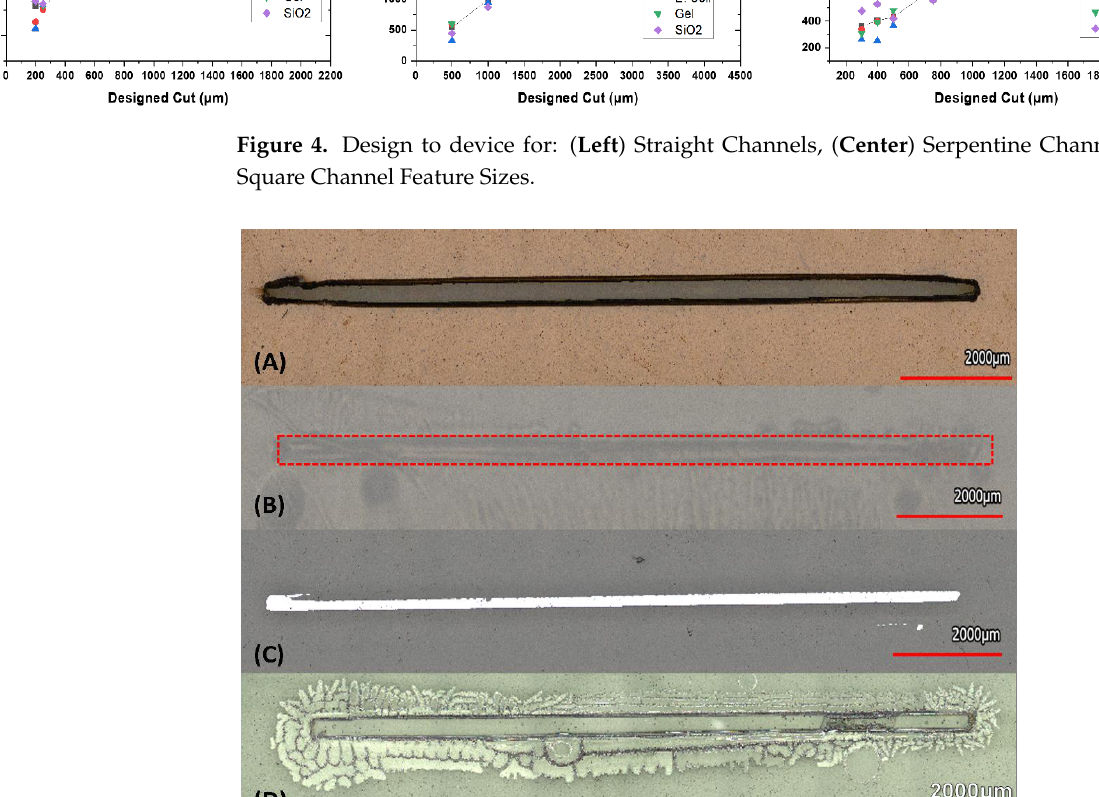
Figure 5. Straight Channel Cuts depicting the smallest cuts for ( A ) Stencil Mask, ( B ) E. coli ( C ) Cr, ( D ) Gelatin. Inconsistent Sub 100 μm gelatin structures shown in Figure S6. 2038.7 μm , 1104.7 μm , 858.3 μm , 617.4 μm , and 257.1 μ m, respectively. As described